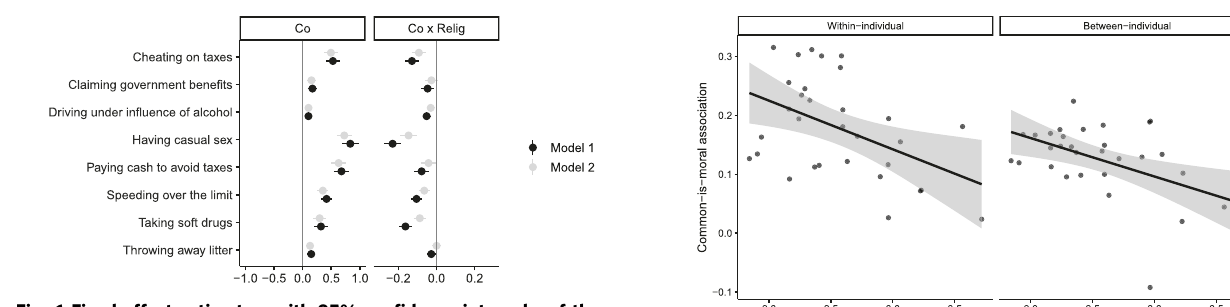
Fig. 6 Fixed effect estimates, with 95% con fi dence intervals, of the common-is-moral association (Co) and its moderation by religiosity (Co × Relig) using mixed-effect model M1 with (black) and without (grey) inclusion of the control variables and their interaction with Co. All predictors are centred at the country